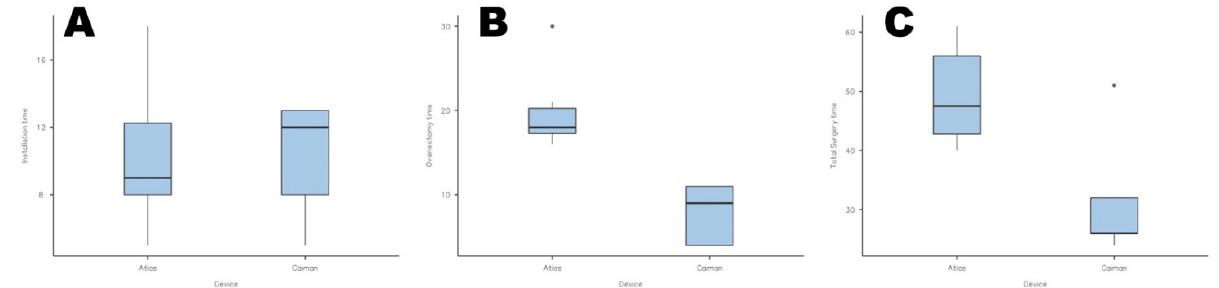
Figure 5. Box plots representing the installation time ( A ), ovariectomy time ( B ), and total surgery time ( C ), respectively for the Atlas and Caiman groups. Statistical differences ( p < 0.05) were observed or the ovariectomy time and total surgery time. Dots represent outliers.